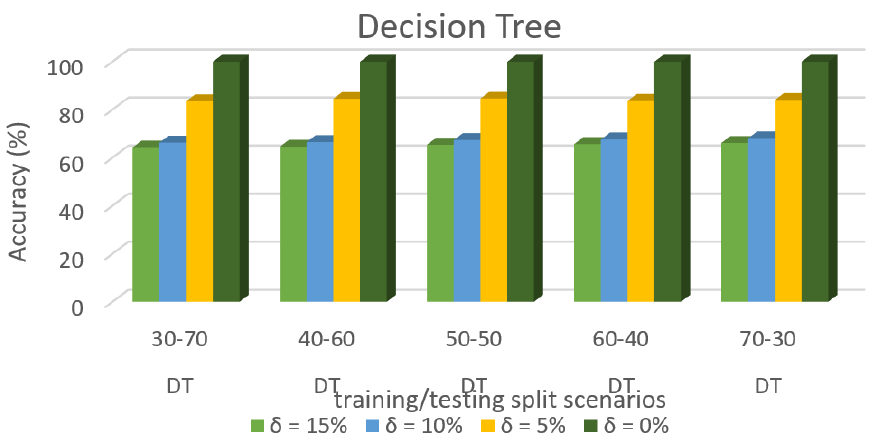
Figure 15. Accuracy Prediction for Dataset 2 using Decision Tree Algorithm.